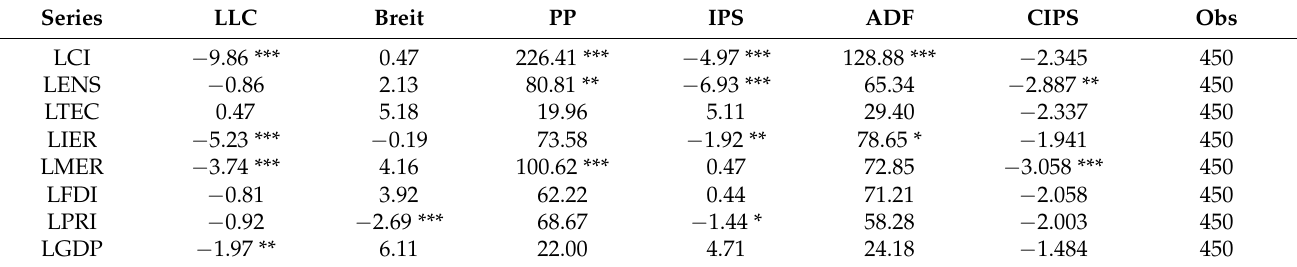
Table 3. Results of unit root